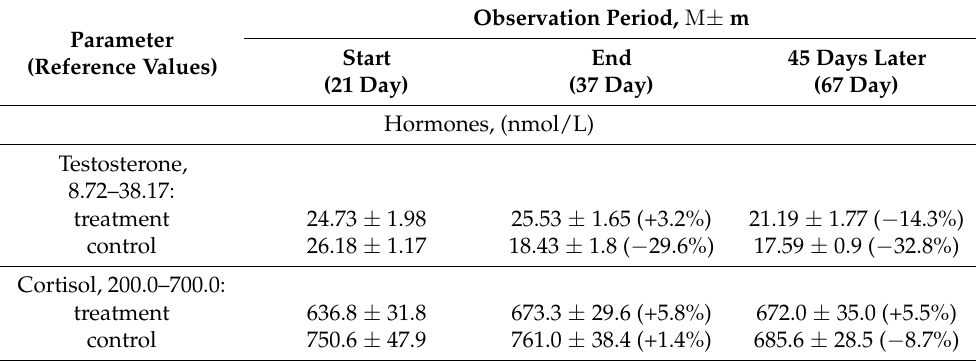
Table 5. Changes in the hormone content during the observation period